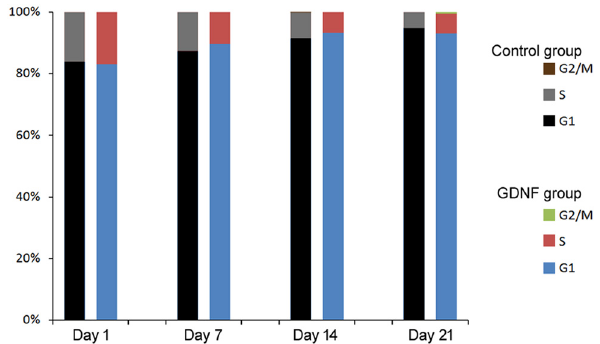
Figure 2: E ff ect of GDNF on BMSC cell cycle. Cell cycle analyses of bone marrow stromal stem cells were performed by fl ow cytometry. * p < 0.05 vs control group.